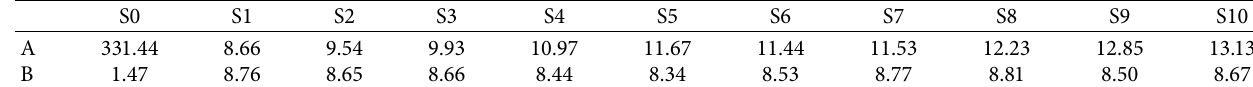
Figure 9: The deformation of specimen S2 under the normal stress. Table 2: The parameters of stress-strain curve fitting equations.